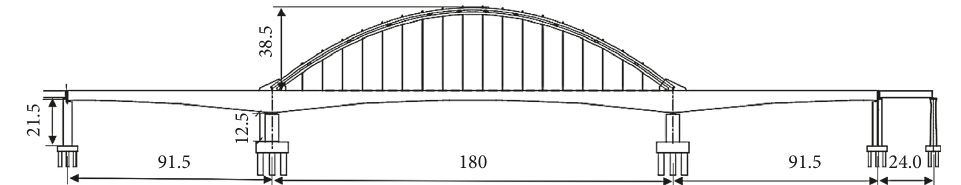
Figure 13: The overall size of the Chengjiang bridge (unit: m).